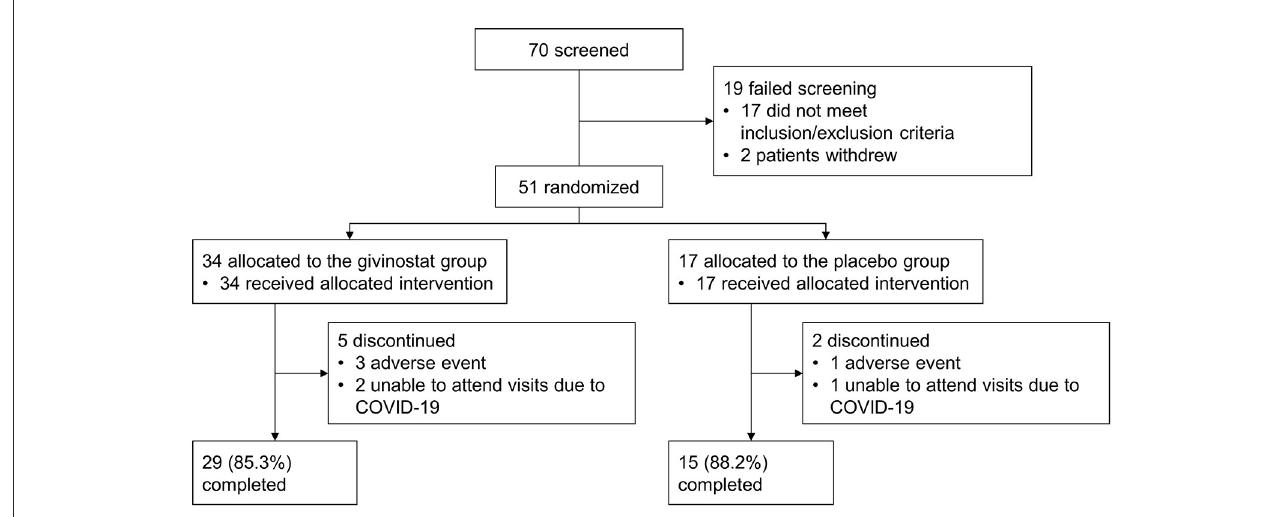
FIGURE1 Patient